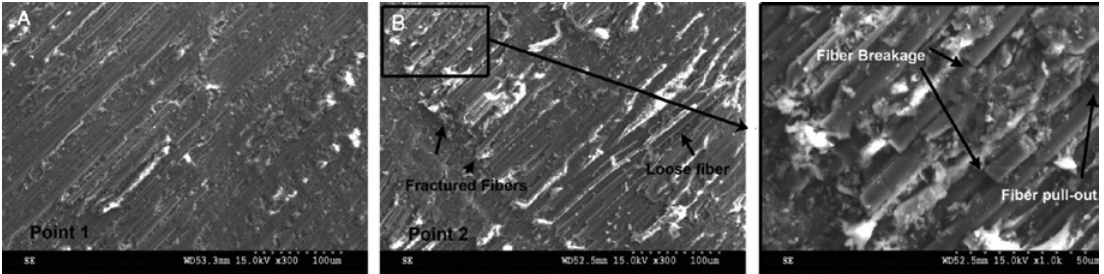
Figure 8: Effect of cutting speed on the quality of machined surface, lead angle 0 ° : (A) cutting speed 250 m/min and feed rate 0.063 mm/rev and (B) cutting speed 375 m/min and feed rate 0.254 mm/rev.